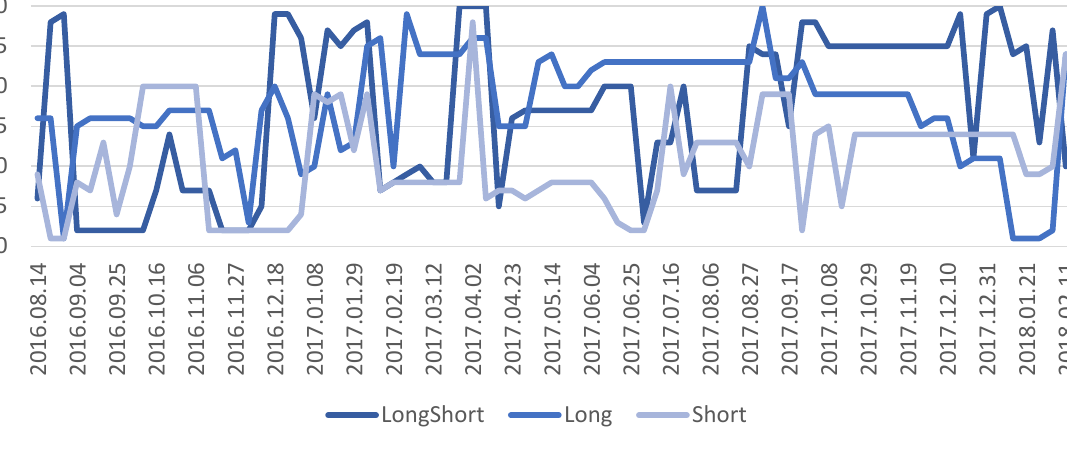
Figure 9. A diagram that shows the values of the backtesting periods (in number of weeks) for the three PIVOT systems for COTTON